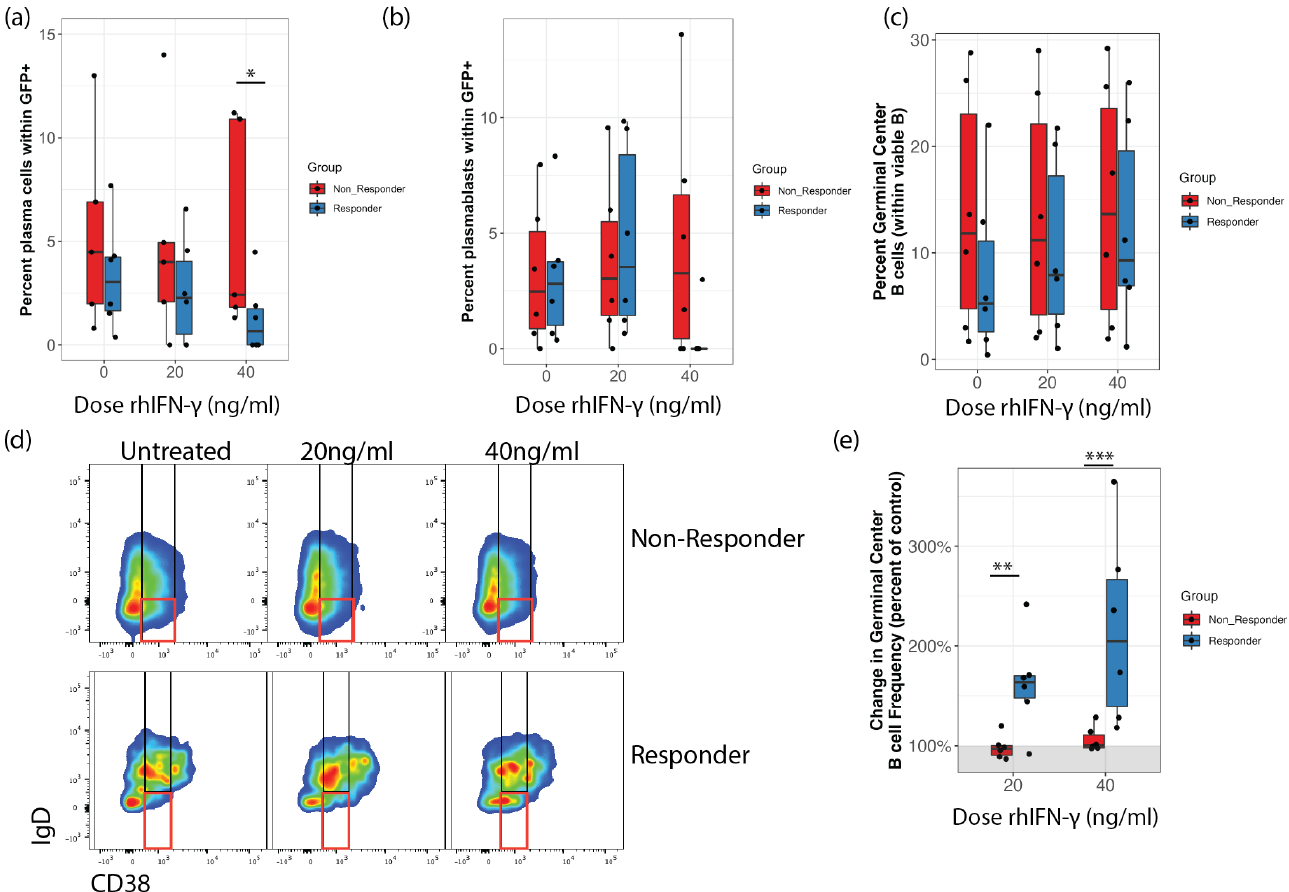
Figure 2. IFN- γ inhibition of KSHV infection in B cells is associated with decreased infection of plasma cells and increased germinal center B cell frequencies. B cells derived from 12 unique tonsil specimens were infected with KSHV and cultured in a reconstituted total lymphocyte environment with the indicated doses of IFN- γ . At 3dpi cells were analyzed for KSHV infection (GFP+) and B cell immunophenotypes by flow cytometry. Samples were grouped into responder (blue) and non-responder (red) based on data in Figure 1 ( a ) the percentage of plasma cells within GFP+ cells. Wilcox test * p = 0.05 comparing groups at 40 ng/mL ( b ) the percentage of plasmablasts within GFP+ cells. ( c ) frequency of germinal center B cells within viable B Repeated measures ANOVA significant effect of IFN- γ treatment in responders only p = 0.009 ( d ) representative flow cytometry data showing the frequency of germinal center B cells (red gates; see Table 1 for detailed subset definitions) within viable B in a non-responder (top) and responder (bottom) sample at indicated doses of IFN- γ . ( e ) data as in ( c ) normalized to untreated controls (IFN- γ treated/sample-matched control). Wilcox test ** p = 0.03, *** p < 0.01.